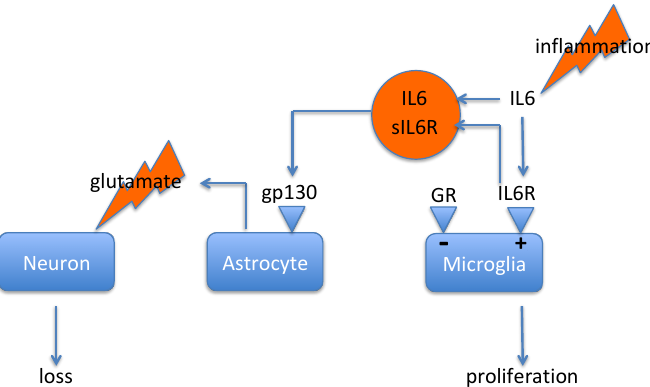
Figure 2. This scheme is based upon data published by [143] . It assumes that inflammation causes interleukin-6 (IL6)-release and shedding of sIL6R from microglia. Trans-activation of astrocytes would lead to the ‘neurotoxic-reactive’ phenotype that may cause damage to neurons. Activation of the glucocorticoid receptor would limit the inflammation-induced sequence of events. Legend: sIL6R, soluble IL-6-receptor.